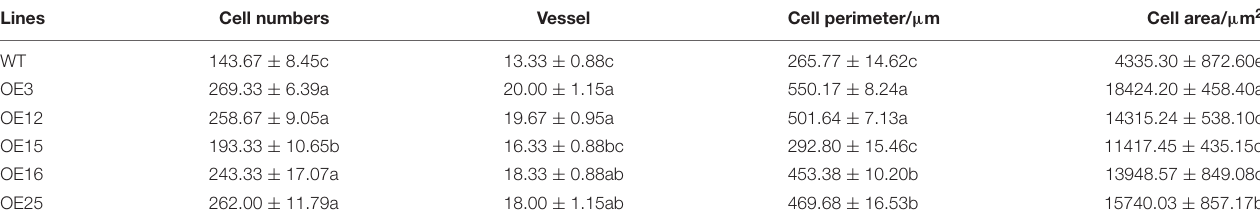
TABLE 2 | Stem microstructure indexes of WT plants and OE-MsASMT1 transgenic plants. Lines